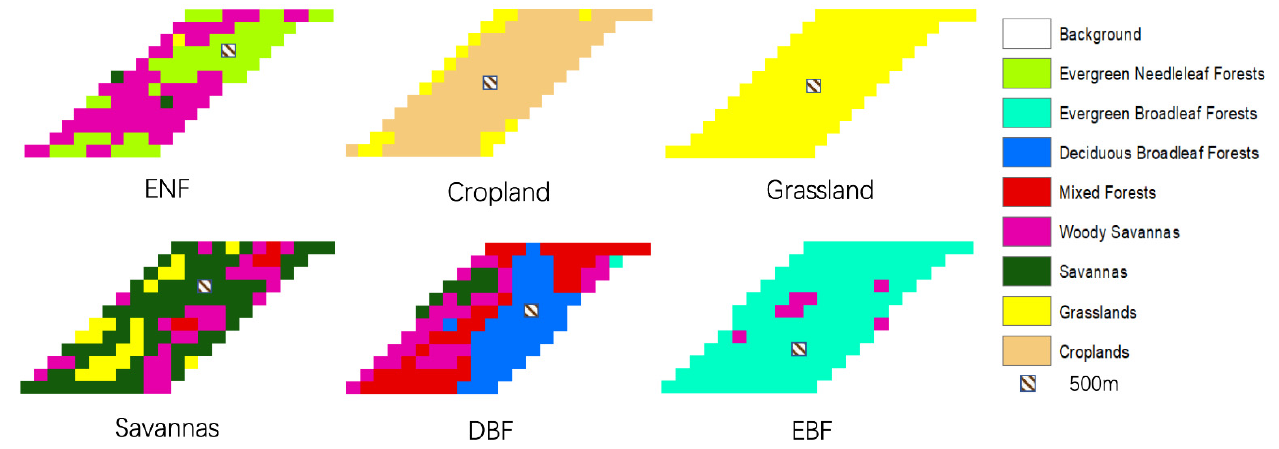
Figure 1. The distributions of land cover types at 500 m for each study site within MODIS pixels (5600 m).